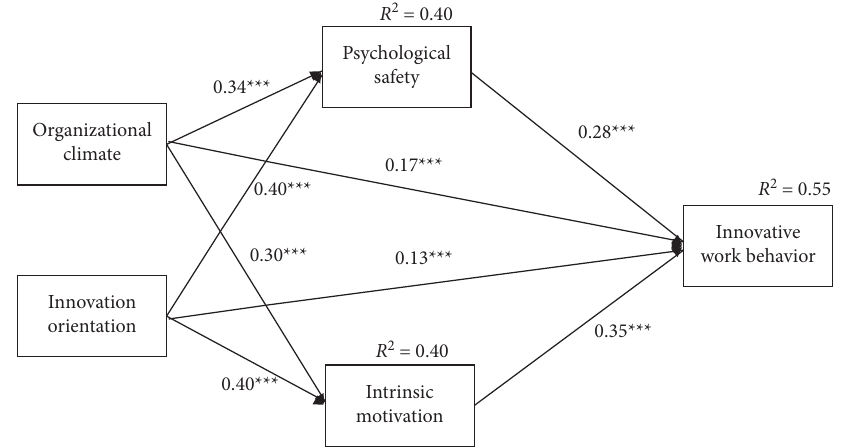
Figure 3: Structural Model. Notes: ∗∗ p < 0 . 01 and ∗∗∗ p < 0 . 001; standardized coefficients are reported. Table 3: Standardized direct, indirect, and total